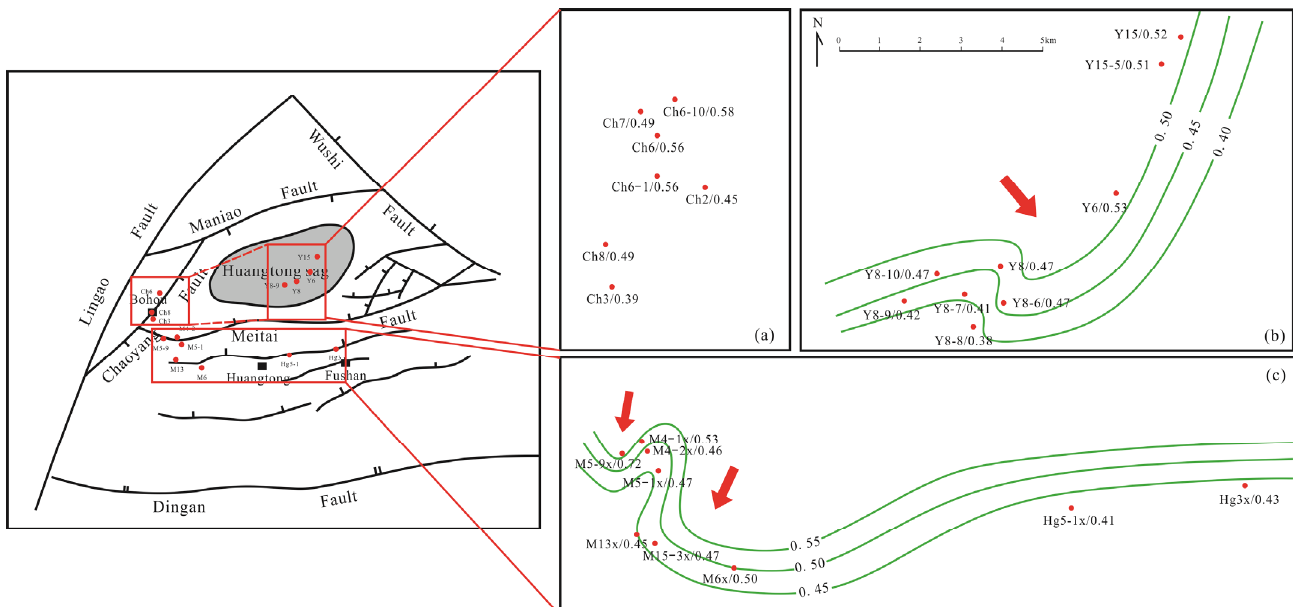
Figure 13. Isopleth map of 1-/4-MDBF of oils showing the oil migration orientation and charging pathways in the Chaoyang area ( a ), Yong’an area ( b ), and Hongguang-Meitai area ( c ). Note: MDBF, methyldibenzofuran.